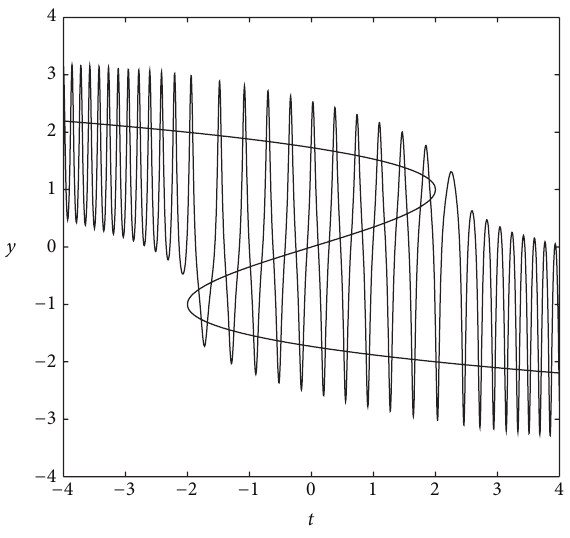
Figure 5: Solution of (29), 𝜖 2 = 0.00354 on ⟨−4, 4⟩ .